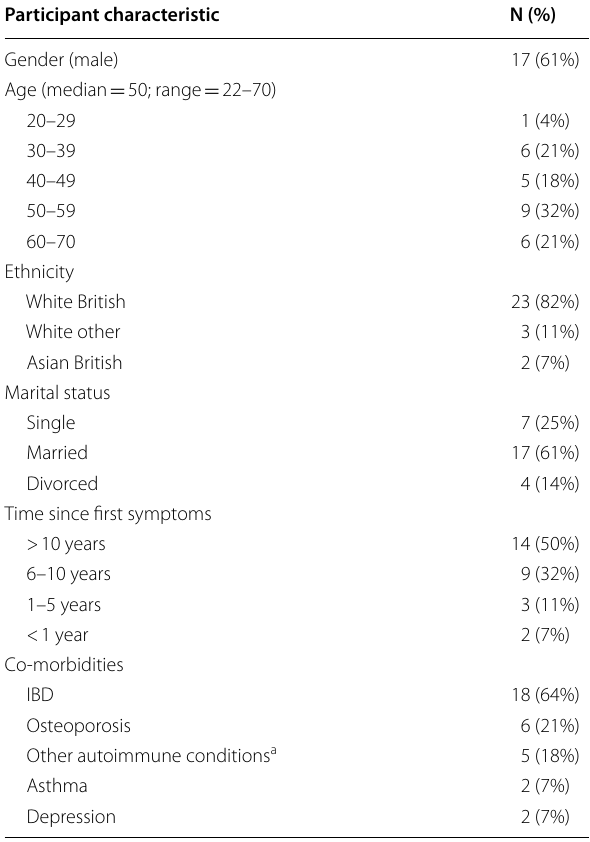
a Ankylosing spondylitis, psoriasis, pulmonary sarcoidosis, rheumatoid arthritis